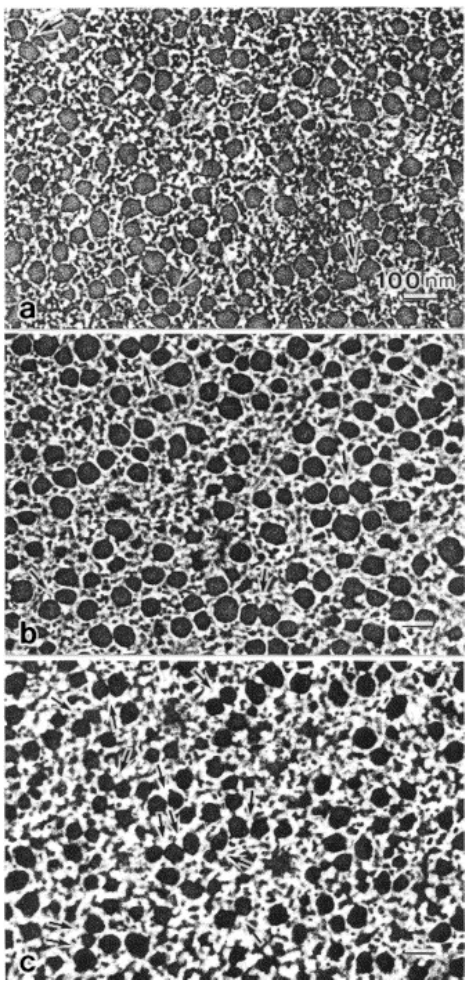
Figure 7. Cross-sections of the ABRM fibers, quickly frozen at rest ( a ), during active tension development ( b ), and during the catch state ( c ). In ( c ), the thick filaments are occasionally interconnected either directly or by projections, as indicated by arrows. Bar, 100 nm. (Takahashi et al. [36]).